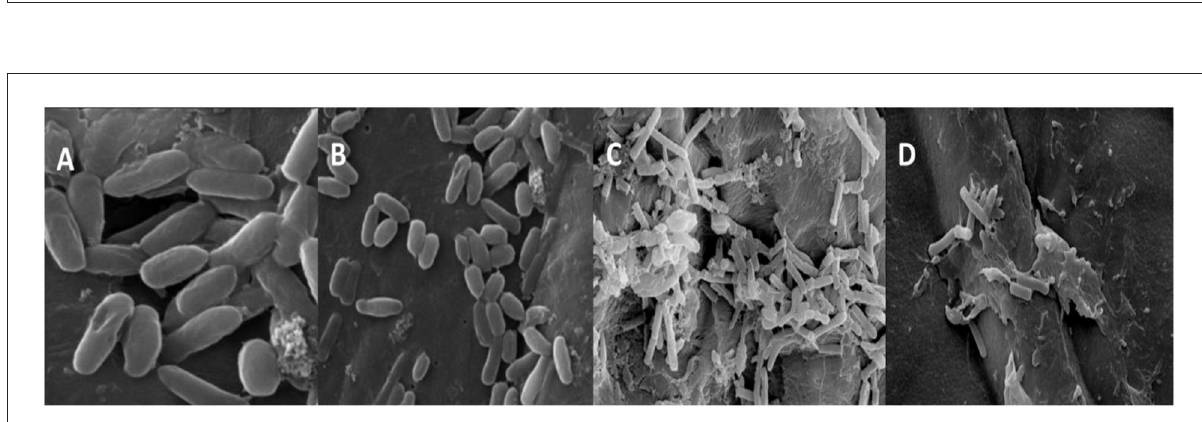
FIGURE9 SEM images of P. gingivalis (A,B) control and treated with biogenic ZnO NPs and A. faecalis control and treated (C,D) with biogenic ZnO NPs.